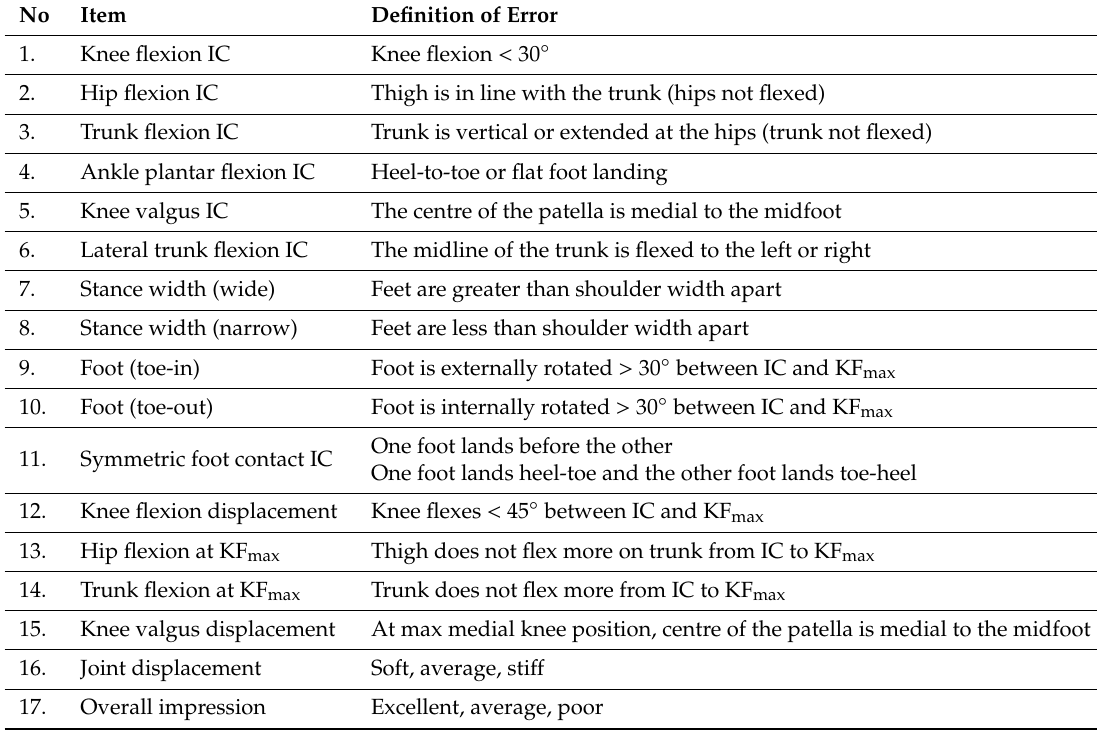
Table 1. Landing Error Scoring System operational definitions of errors. (Adapted from Padua et al.